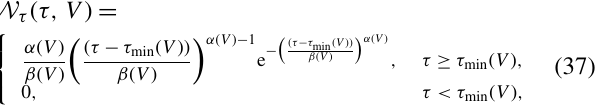
Fig. 5.21 of Emeis (2013), which reports the variation in TI as a function of hub